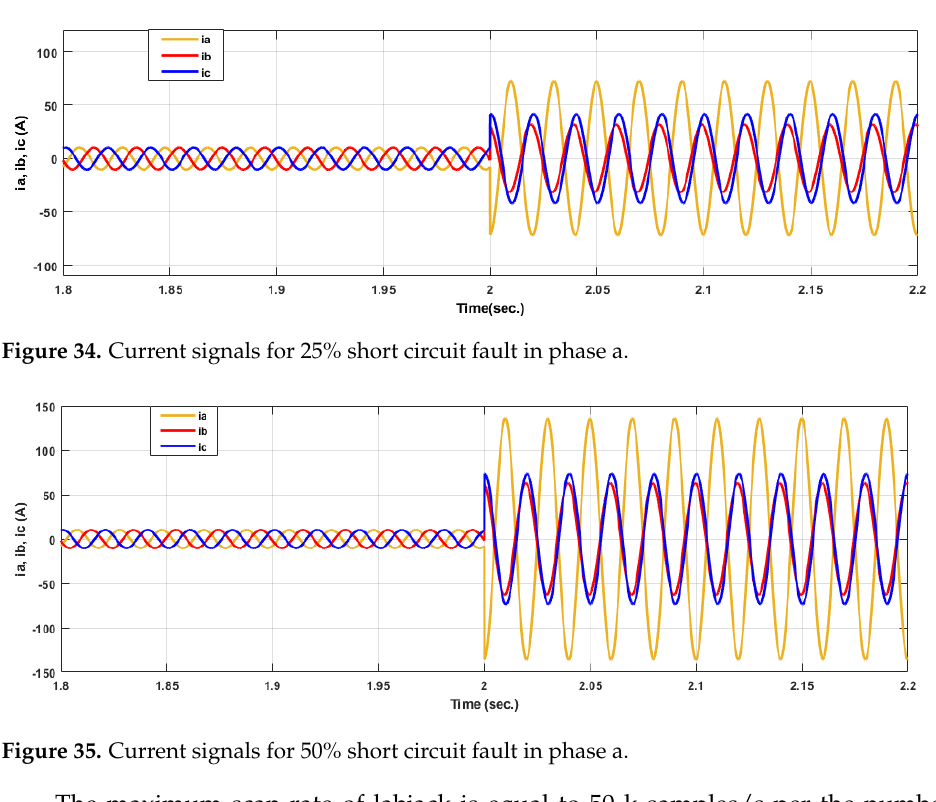
Figure 33. Current signals for 10% short circuit fault in phase a and phase b.